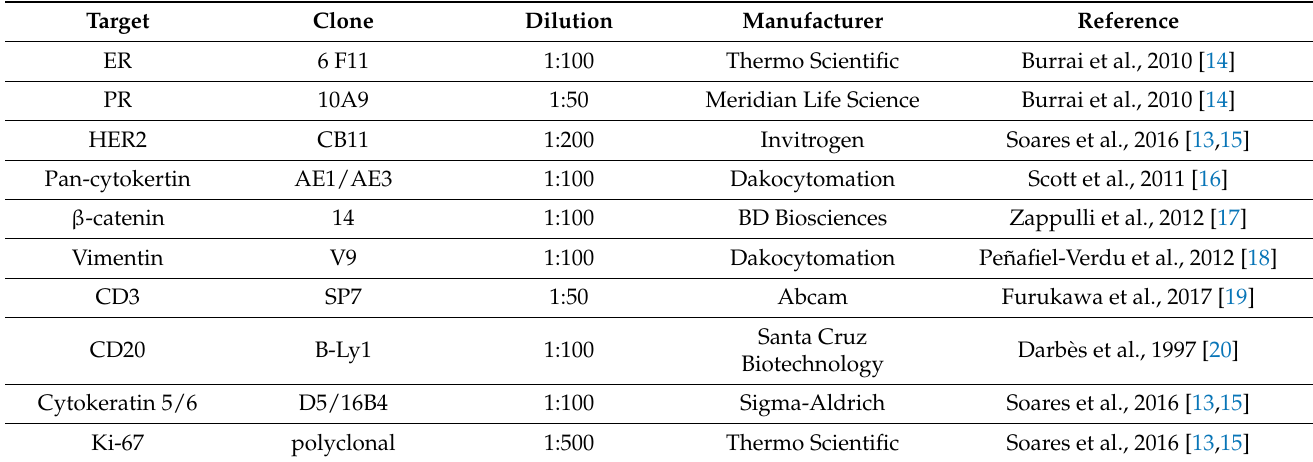
Table 1. Antibodies applied for the immunohistochemical examination.